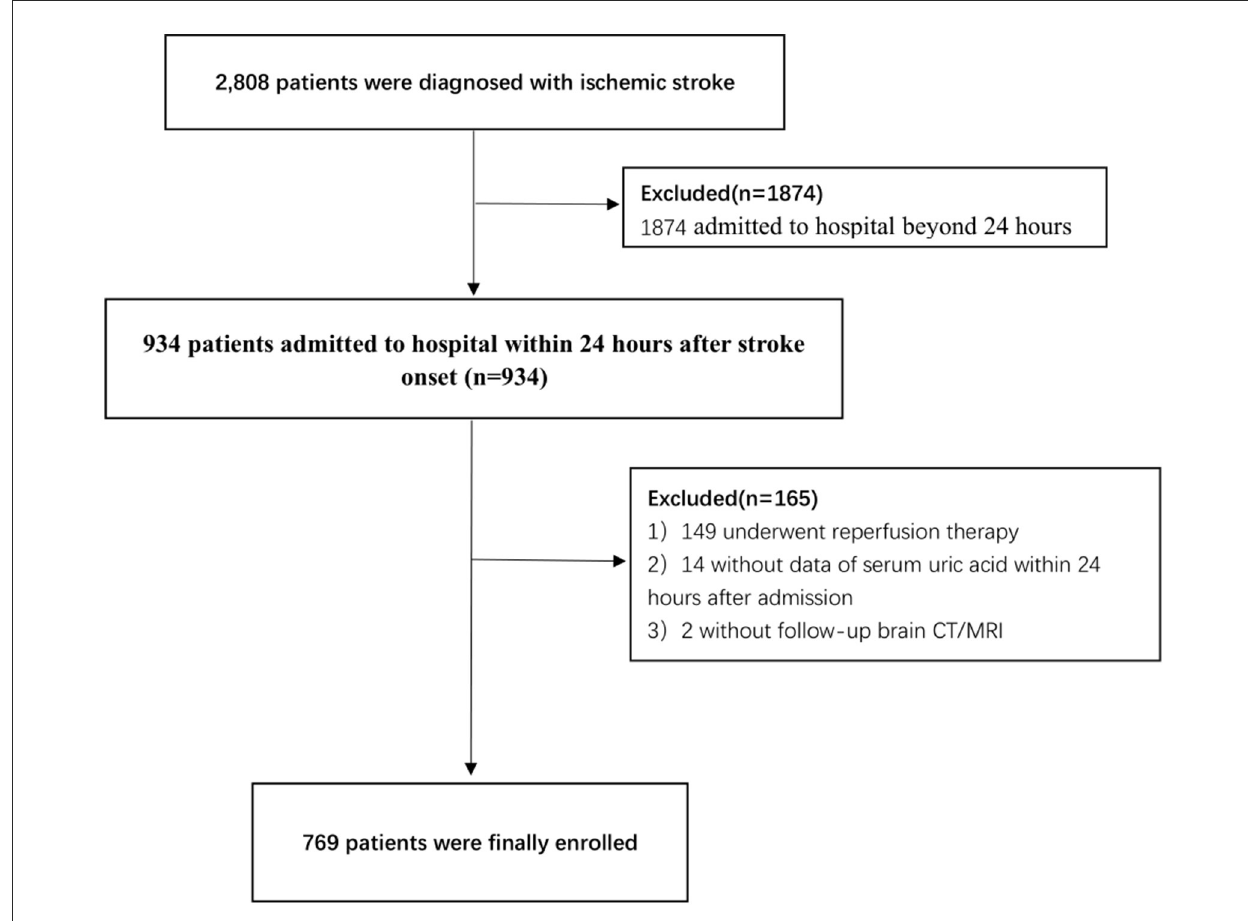
FIGURE1 Flowchart of patients’